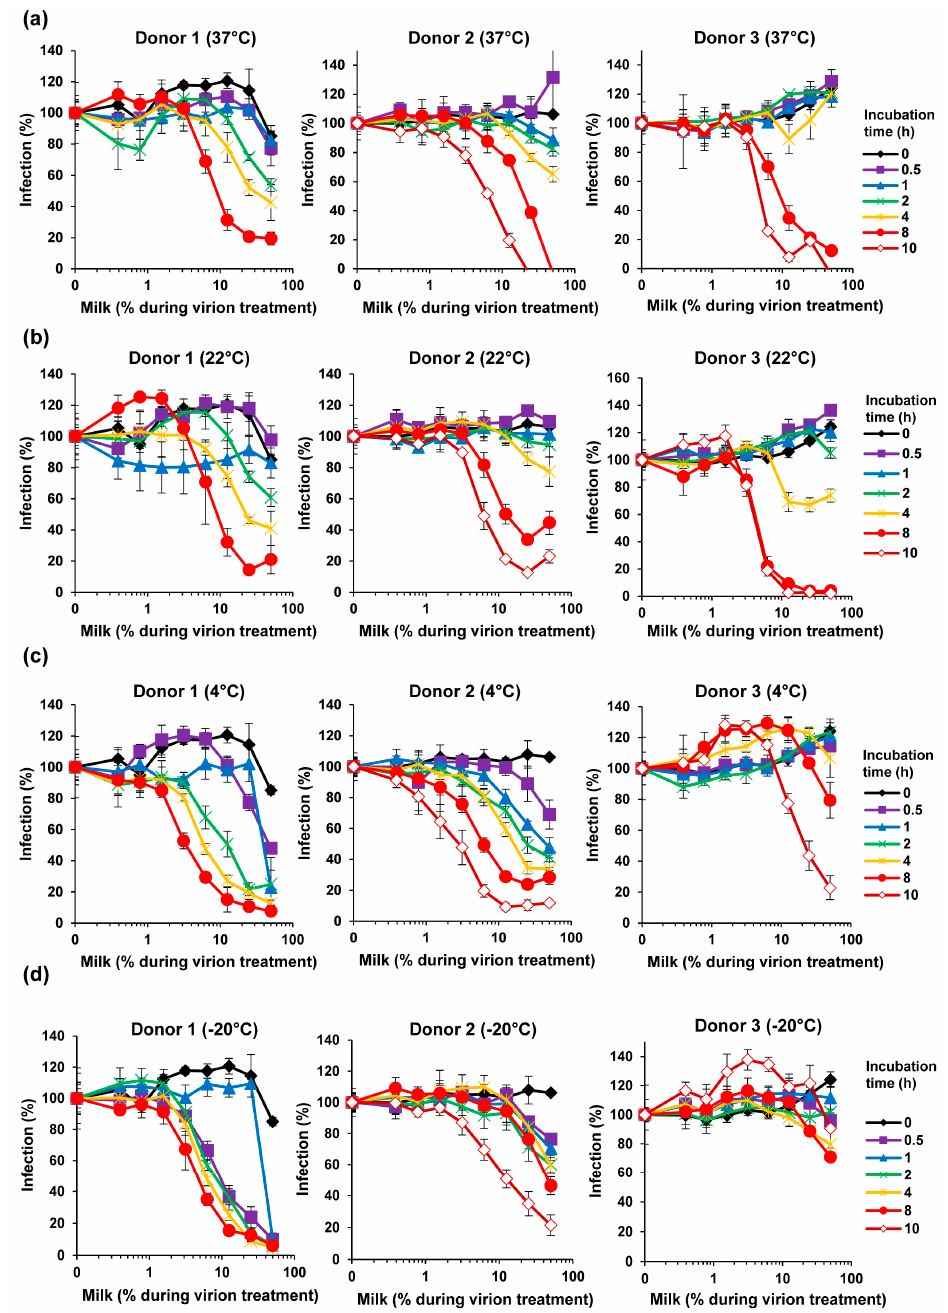
Figure 5. E ff ect of storage and temperature on the anti-ZIKV activity of milk. Fresh breast milk was received from three donors and, after 30 min, was mixed 1:1 with ZIKV MR766 (1.58 × 10 7 TCID 50 / mL) at indicated concentrations and incubated for 10 min at room temperature. Mixtures were then diluted 10-fold onto Vero E6 cells and incubated for 2 h before the medium was changed. Additionally, the breast milk was incubated at ( a ) 37 ◦ C, ( b ) 22 ◦ C, ( c ) 4 ◦ C, or ( d ) − 20 ◦ C for indicated time points before mixing with ZIKV and inoculation of Vero E6 cells. Infection rates were determined 2 days later by a cell-based immunodetection assay that enzymatically quantifies the flavivirus protein E. Infection data are normalized to infection rates in the absence of the respective breast milk sample and represent average values obtained from triplicate infections ± standard deviations. See also Figures S3–S6. 3.5. Loss of ZIKV Infectivity in Milk Stored at 4 °C